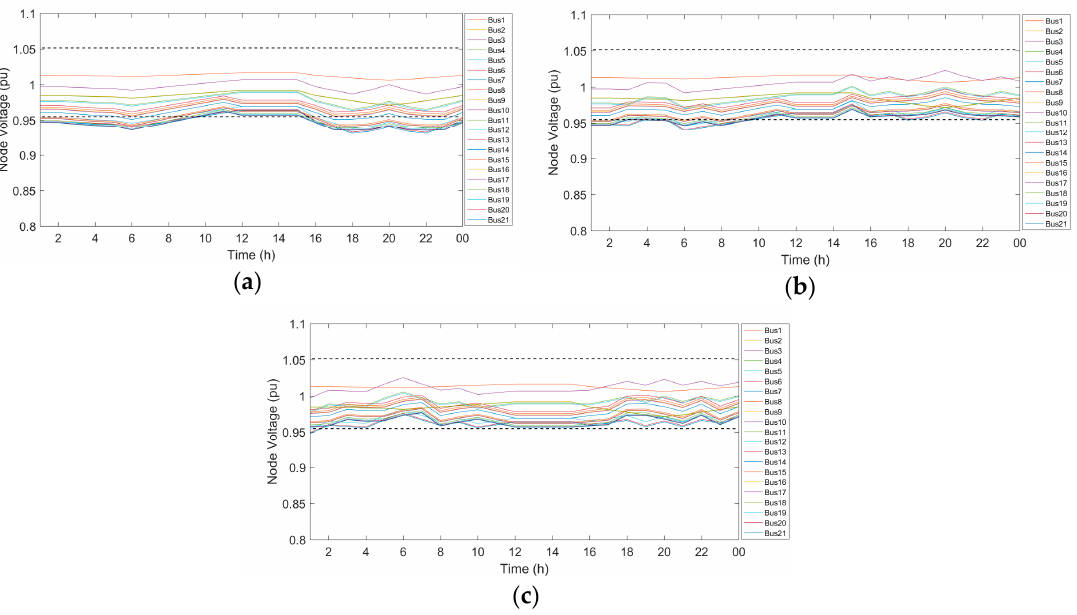
Figure 6. Node voltages of solution B for all tap position constraints ( g A – g C ). ( a ) Node voltages (equality constraint of g A ); ( b ) node voltages (equality constraint of g B ); ( c ) node voltages (equality constraint of g C ).